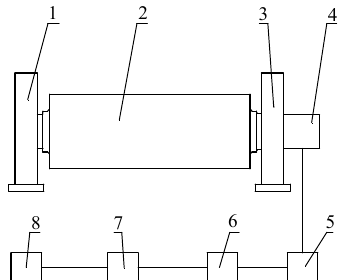
Figure 1. System of entire roller-embedded shapemeter. 1, transmission side bearing seat; 2, shapemeter roll; 3, operating side bearing seat; 4, self-generating signal processing and wireless transmitting device; 5, wireless receiver; 6, decoder; 7, software processing system; 8, memory and peripherals.